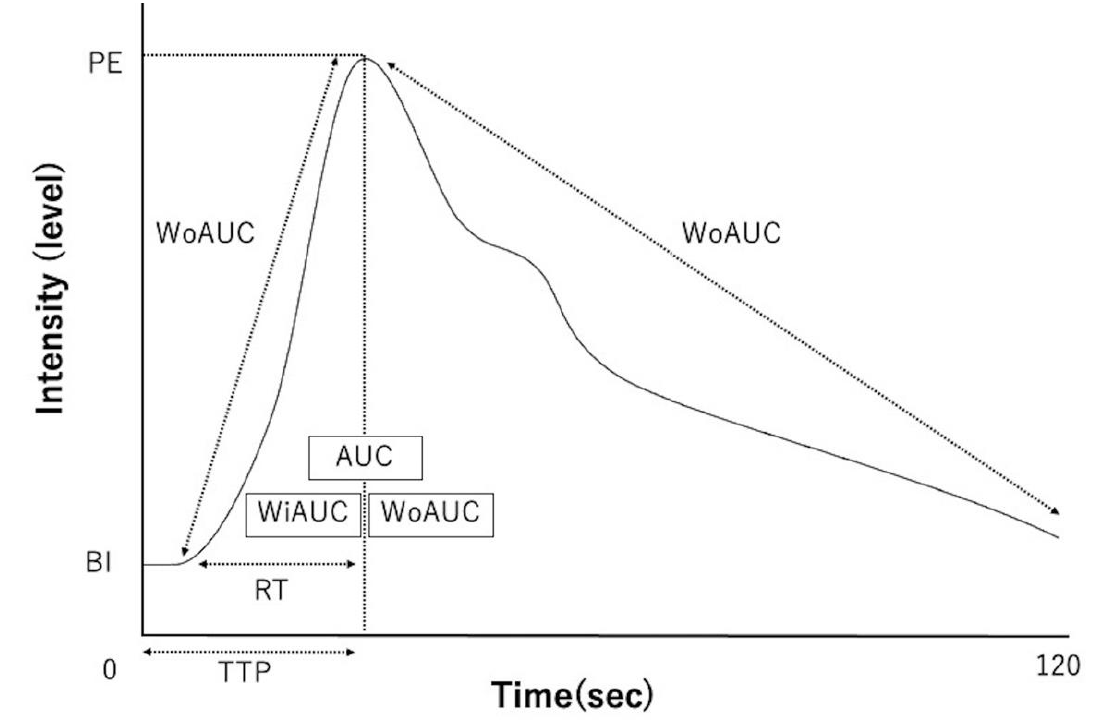
Figure 3. Schematic diagram of time intensity curves and each parameter. TTP — time-to-peak; RT —